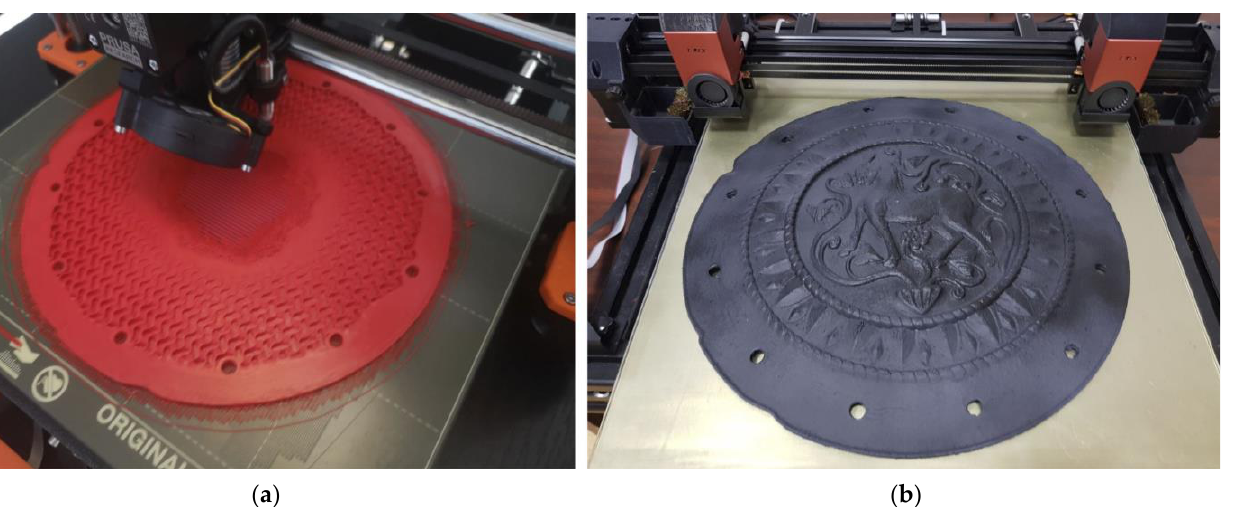
Figure 27. The mobile device augmented reality application.